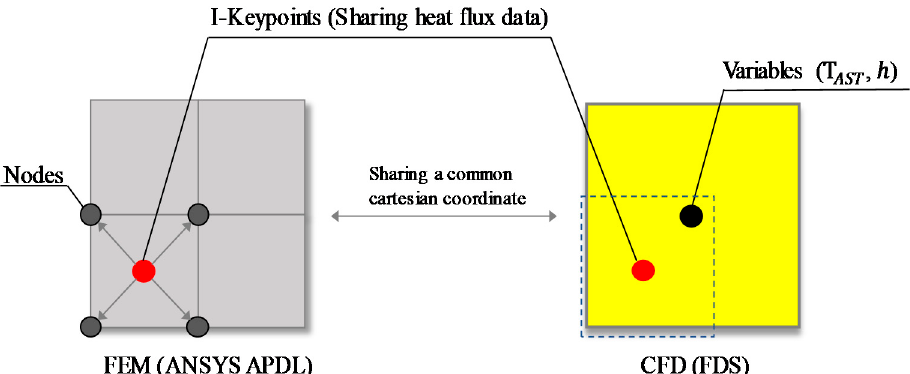
Figure 2. Extent of the concept of the mapping procedure between the finite element method (FEM) and a computational fluid dynamics (CFD) method. FDS: Fire Dynamics Simulator; T AST : adiabatic surface temperature; h : convective heat transfer coefficient; APDL: ANSYS Parametric Design Language.